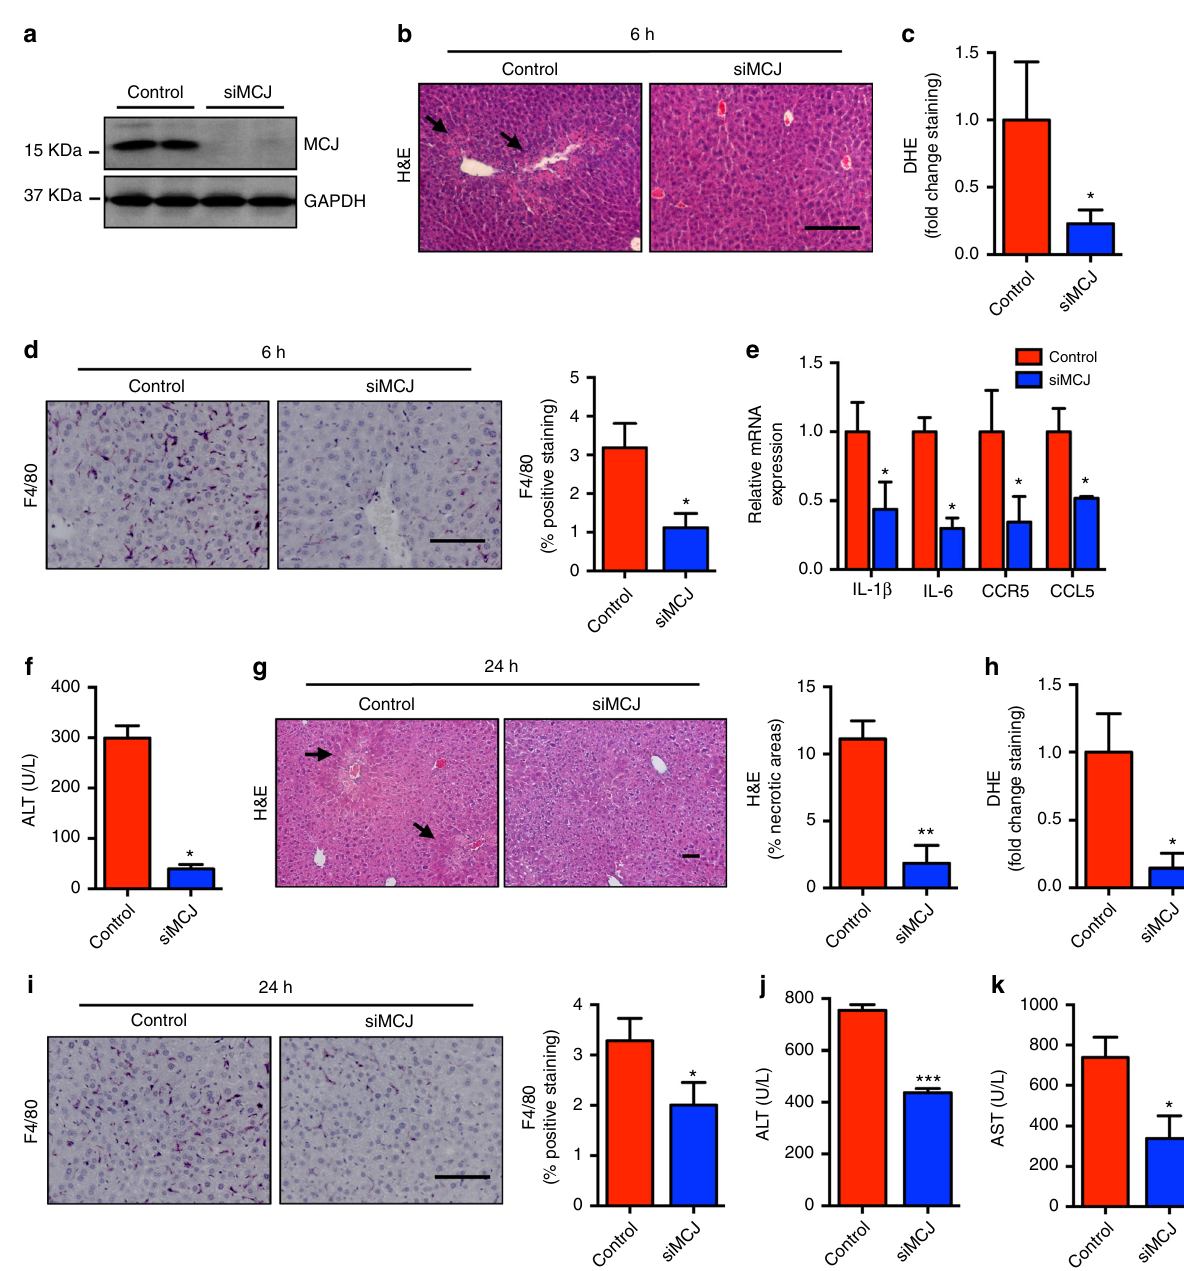
Fig. 3 MCJ liver-speci fi c silencing prevents against APAP-induced liver injury in vivo. a – f WT mice were treated with APAP 360 mg/kg and 6 h after control (Control) ( n = 6) or a MCJ-speci fi c siRNA (siMCJ) ( n = 6) were intravenously injected. a MCJ silencing was evaluated by western blotting, b liver necrosis was assessed by H&E staining, c ROS in vivo measured by DHE staining in liver sections, d in fl ammation assessed by F4/80 staining in liver, e relative mRNA expression of different in fl ammatory genes, f serum ALT levels in Control and siMCJ-treated animals. g – k WT mice were treated with APAP 360 mg/kg and 24 h after control (Control) ( n = 6) or a MCJ-speci fi c siRNA (siMCJ) ( n = 6) were intravenously injected. g Liver necrosis was assessed by H&E staining, h ROS in vivo measured by DHE staining in liver sections, i in fl ammation assessed by F4/80 staining in liver, j serum ALT, and k serine aminotransferase (AST) levels in Control and siMCJ-treated animals. Scale bar corresponds to 100 μ m. Values are represented as mean ± SEM. * P < 0.05, ** P < 0.01, *** P < 0.001 (Student ’ s t test) (siMCJ vs. Control)